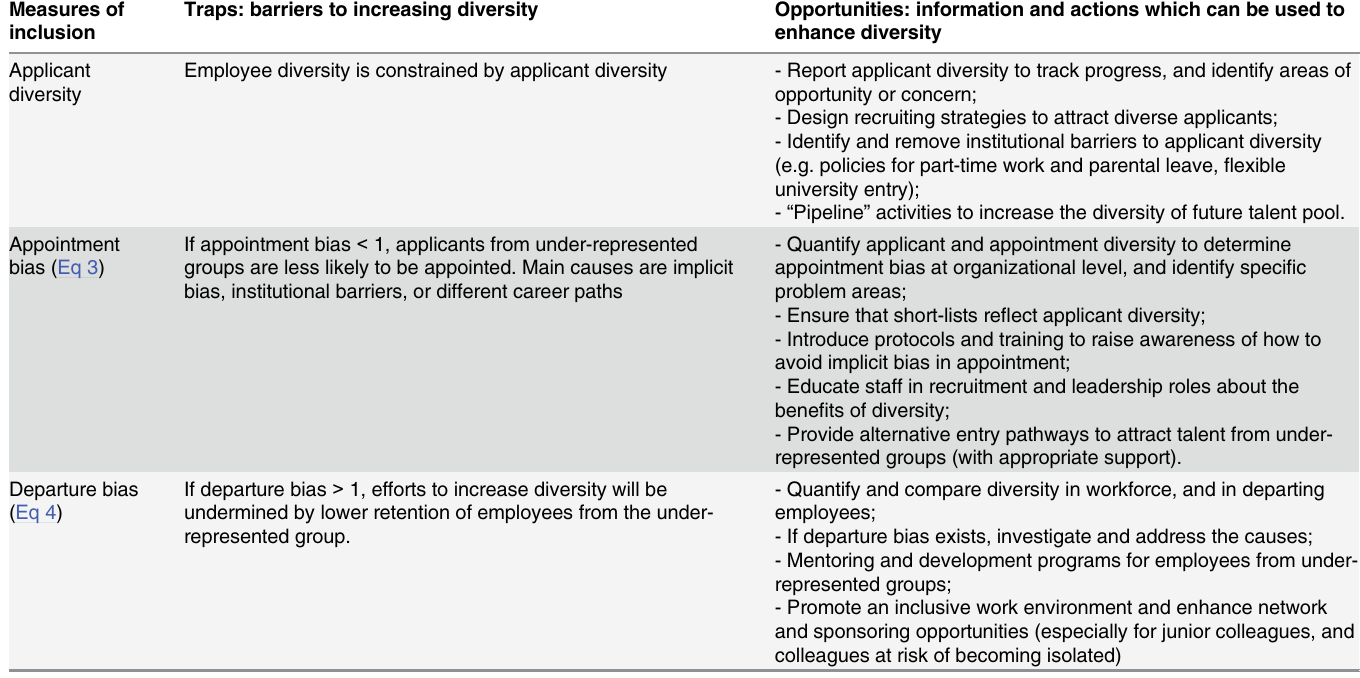
Table 1. Traps and opportunities for increasing workforce